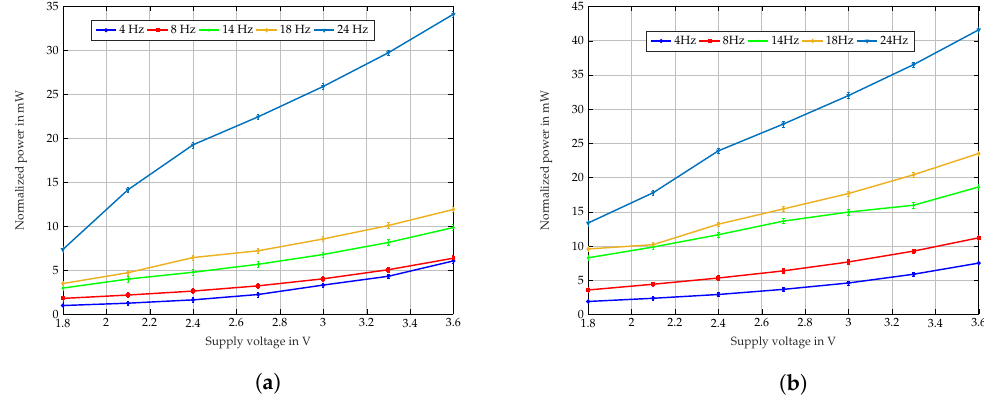
Figure 10. Normalized power vs. supply voltage at various frequencies for ( a ) “nop” operation; ( b ) “add” operation.